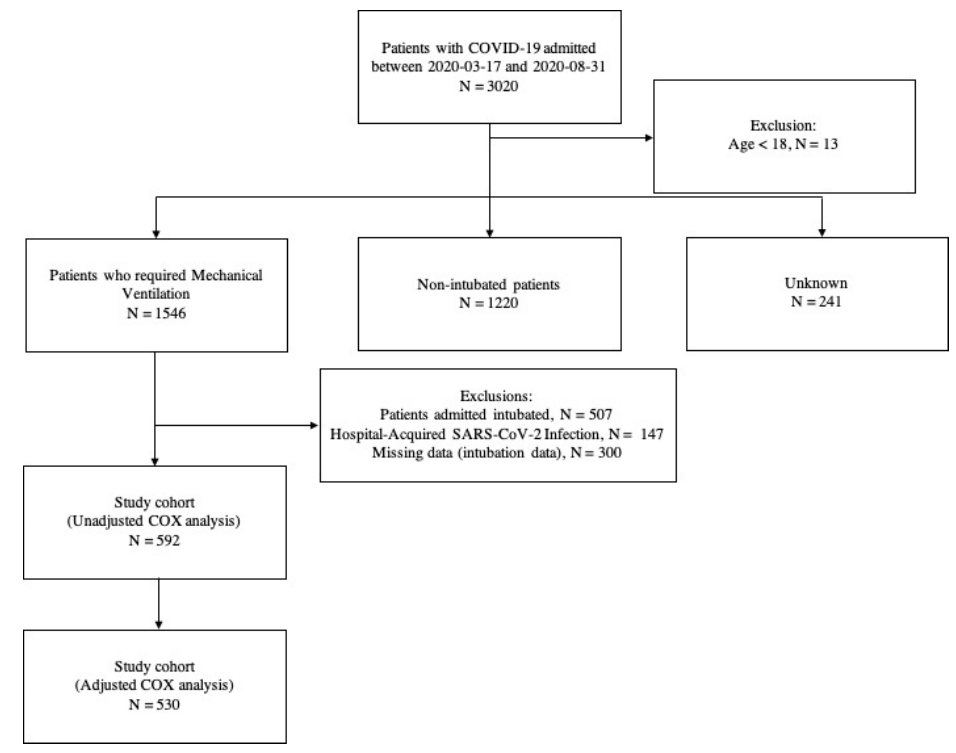
Figure 1. Study cohort.